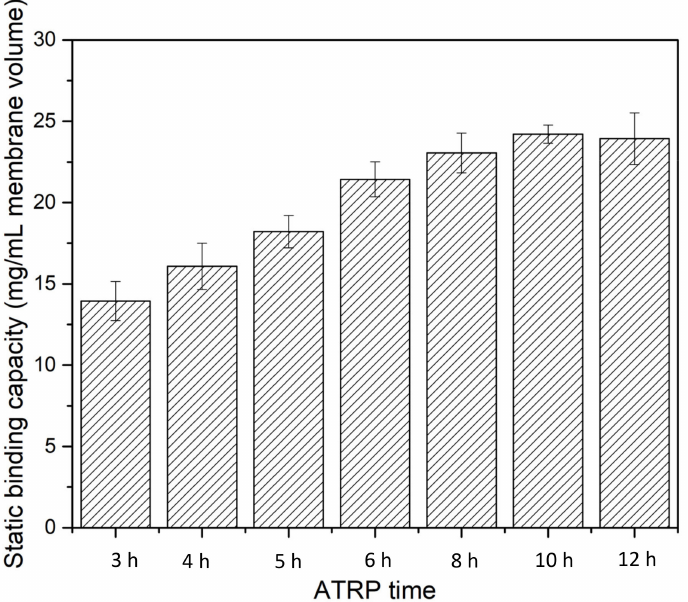
Figure 7. Static binding capacity as a function of polymerization time for PVCL grown on